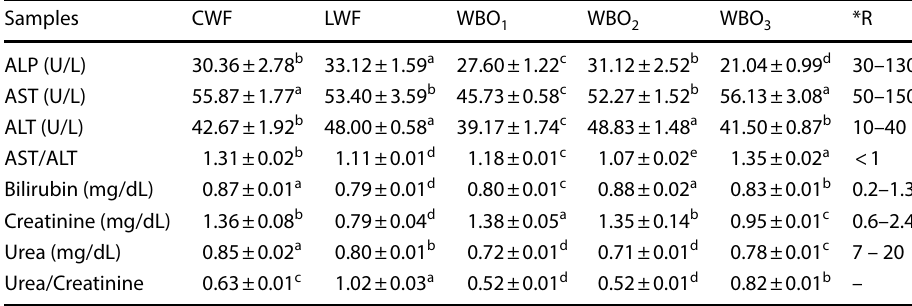
Means ( ± SD) with different alphabetical superscripts in the same row are significantly different at P < 0.05 [75% wheat, and 25% bambara groundnut (WBO 25% wheat, and 75% bambara groundnut (WBO wheat flour (LWF)] Aspartate aminotransferase (AST), alanine aminotransferase (ALT) and Alkaline Phos- phate (ALP) *R: Giannini et al. [89] and